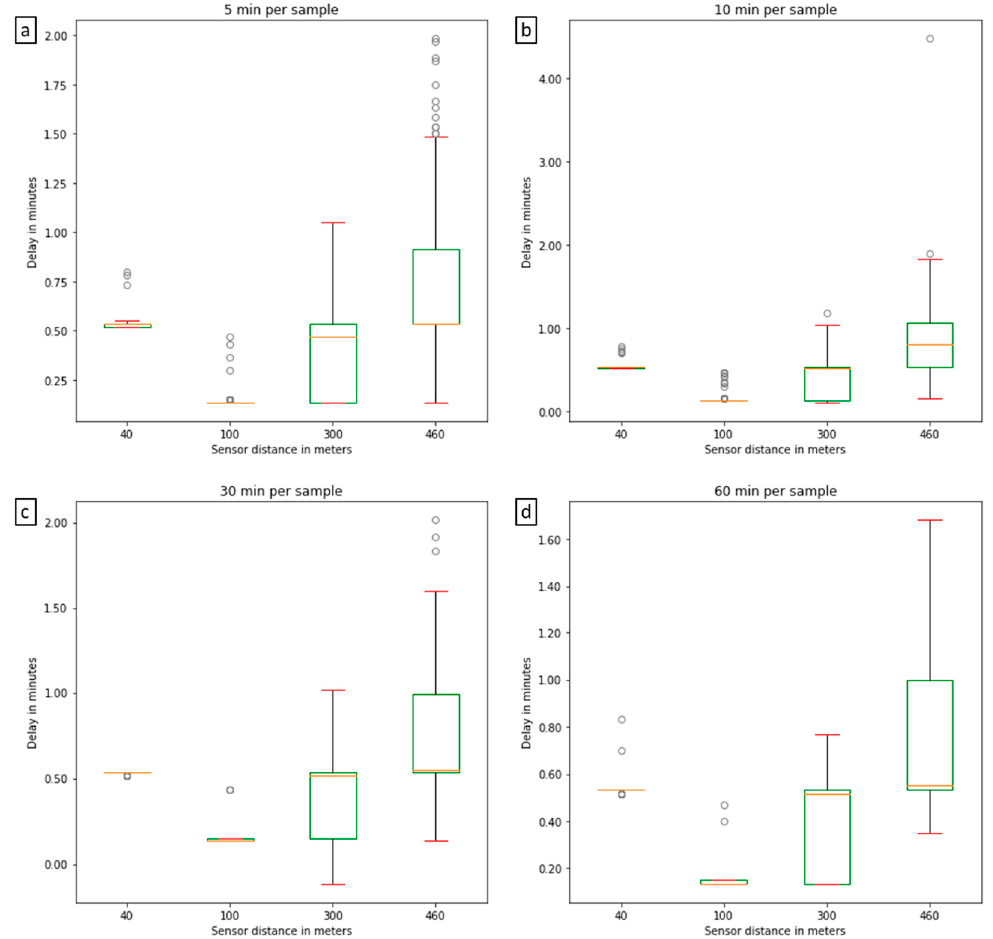
Figure 6. Boxplots of data transmission delay ( a ) 5 min sampling rate, N = 485; ( b ) 10 min sampling rate, N = 825; ( c ) 30 min sampling rate N = 86 and ( d ) 60 min sample rate N = 49; whiskers are calculated as 1.5 times the IQR (interquartile range) and the circles represent the